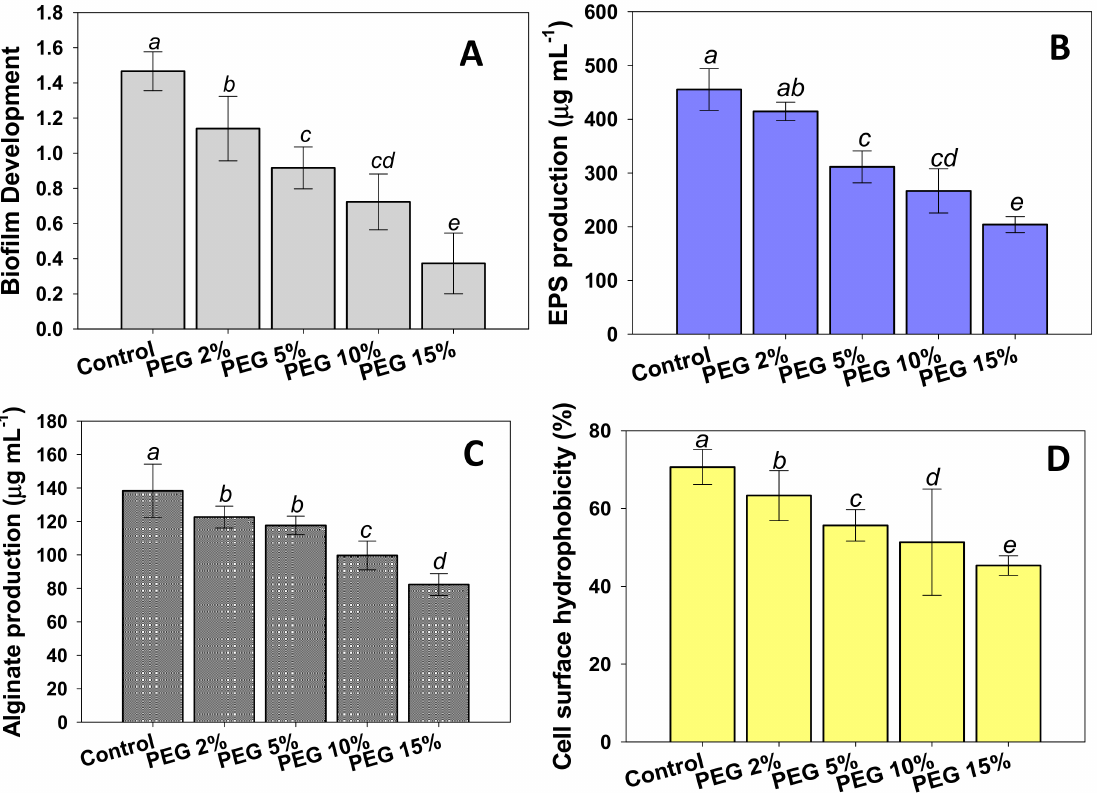
Figure 2. Effects of different levels of water stress (2%, 5%, 10%, and 15% PEG solution) on biofilm development ( A ) and their associated traits; EPS production ( B ), alginate production ( C ), and cell surface hydrophobicity ( D ) of Enterobacter sp./ L. adecarboxylata PAB 19. In these figures, bar diagrams represent the mean values of three replicates. Mean values followed by different letters were significantly different ( p ≤ 0.05) as determined by the Duncan’s Multiple Range Test (DMRT). Bar and scatter plots represent means ±